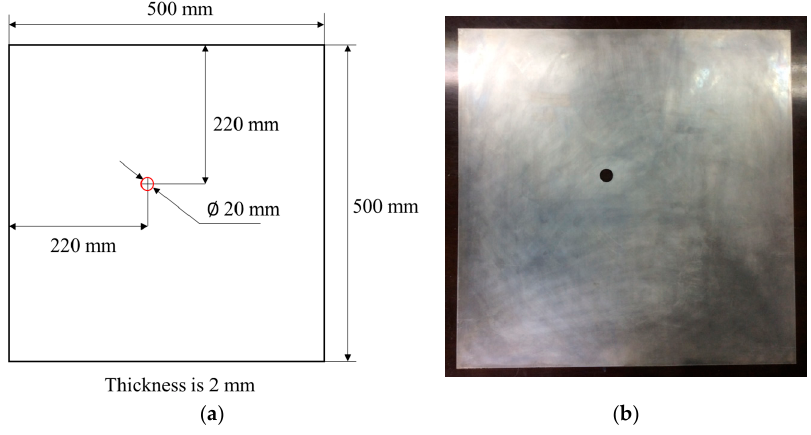
Figure 4. ( a ) The geometry of the specimen and ( b ) the real specimen. Table 1. The properties of PZT sensor.